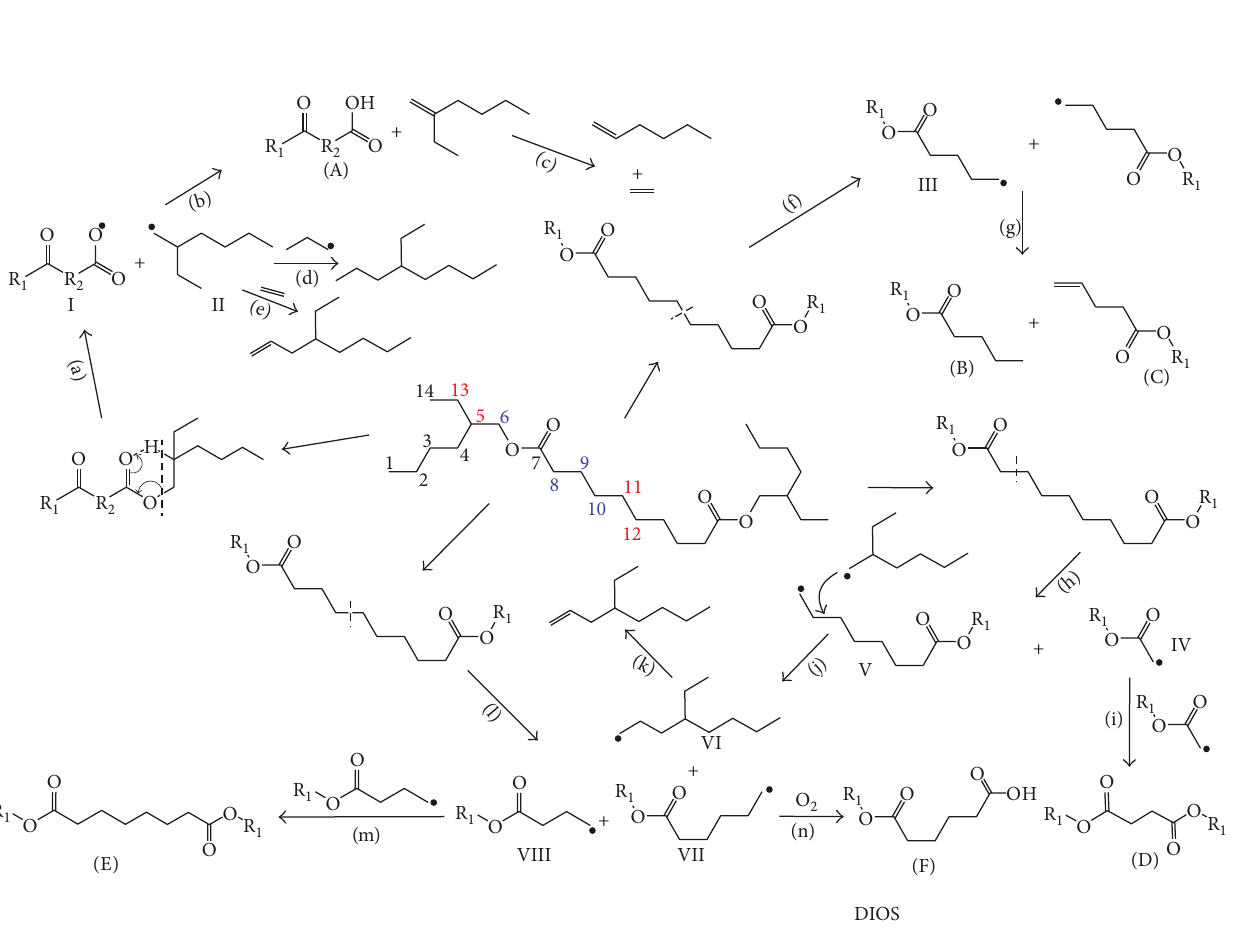
Scheme 1: Possible reaction process of thermal pyrolysis of